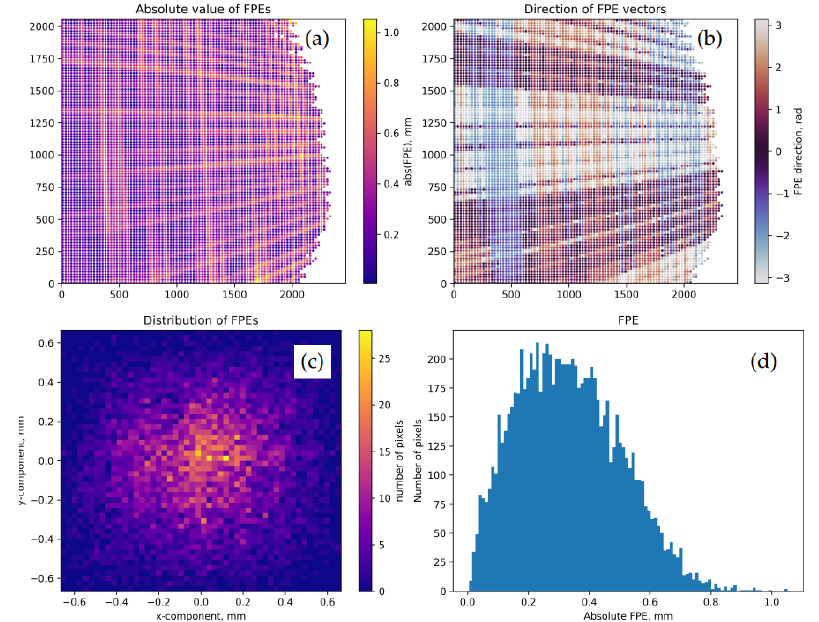
Figure 5. Residual FPEs for the same model and data frame as in Figure 4. ( a ): D FPE mapped over the sensor. ( b ): direction angles tan − 1 histogram of D FPE